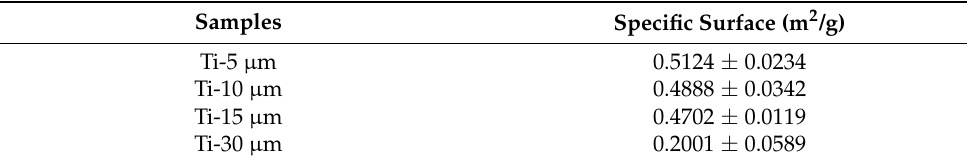
Table 2. Specific surfaces for the different size of samples.